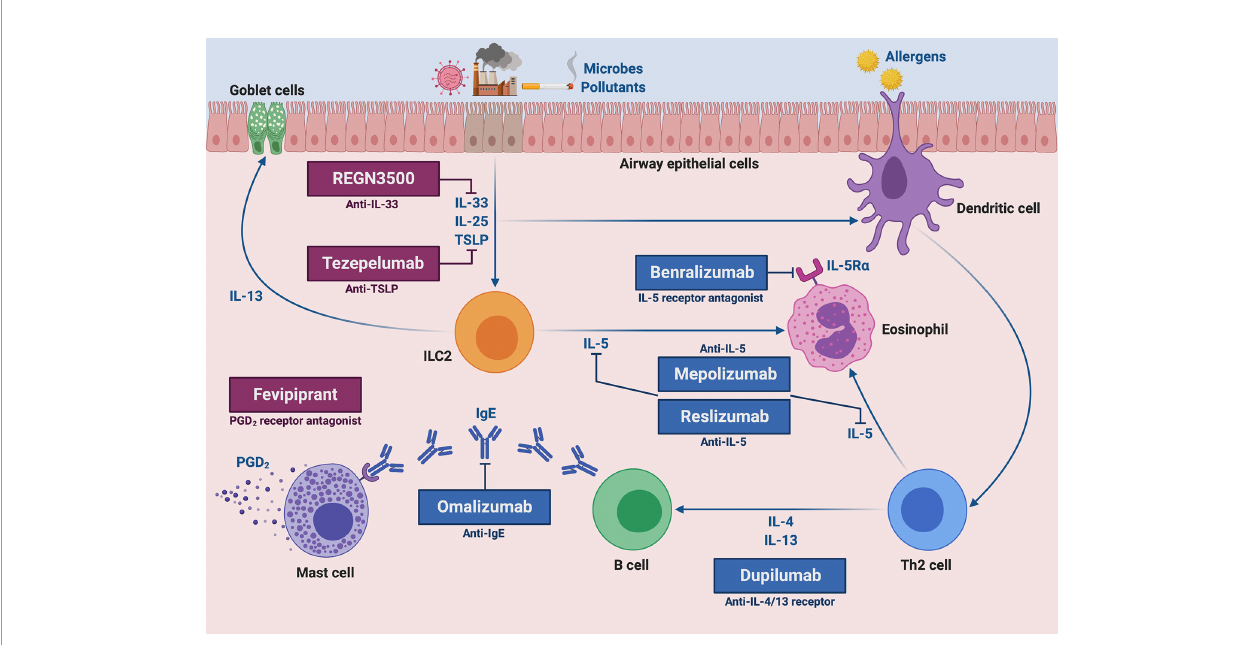
FIGURE 1 | Molecular targets of current and future biological therapies of severe type 2 asthma. The targets of approved add-on biologic treatments (highlighted in blue color) of severe asthma include IgE (omalizumab), IL-5 (mepolizumab and reslizumab), IL-5 receptor (benralizumab), and IL-4/IL-13 receptor complex (dupilumab). Moreover, experimental drugs (highlighted in dark magenta color) such as tezepelumab, REGN3500 and fevipiprant target TSLP, IL-33 and the CRTH2 receptor of PGD 2 , respectively. This original fi gure was created by the authors using “ BioRender.com ”